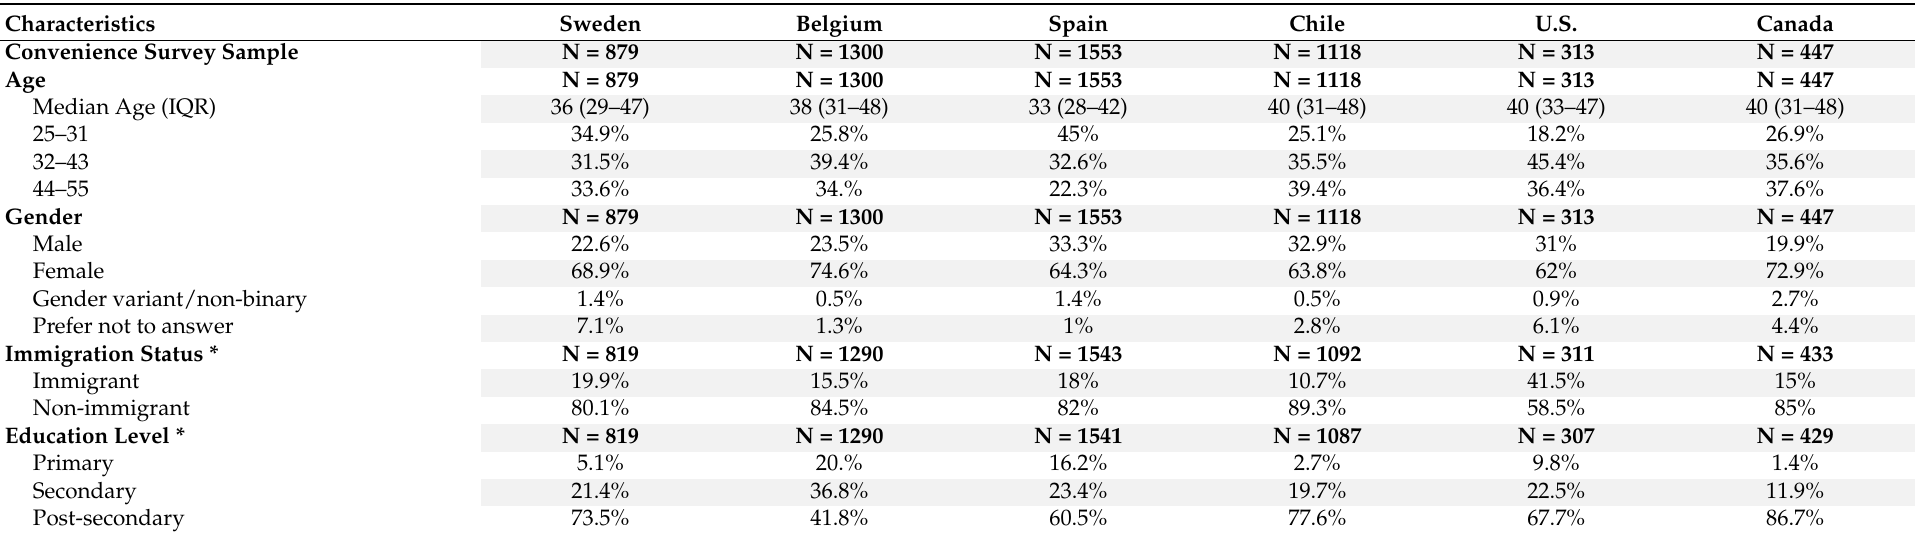
Table 2. Demographic characteristics of the convenience purposive samples across the six